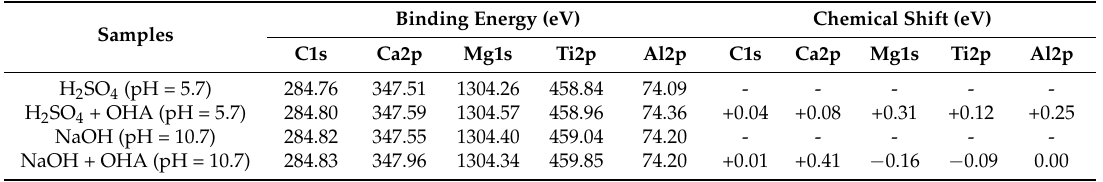
Table 4. Binding energies of elements on titanaugite